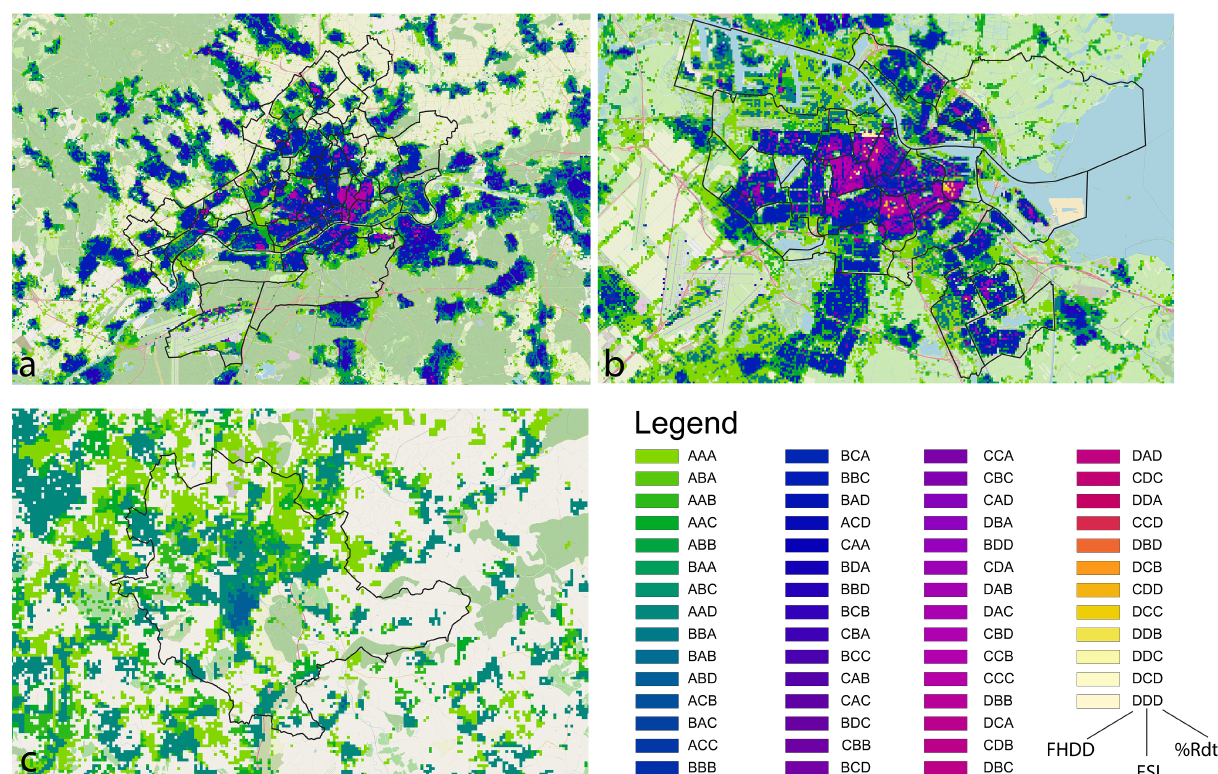
Figure 7. The visualisation of the district typologies in Frankfurt am Main ( a ), Amsterdam ( b ) and Torres Vedras ( c ): FHDD, final heat demand density; FSI , floor space index; %Rdt., share of residential